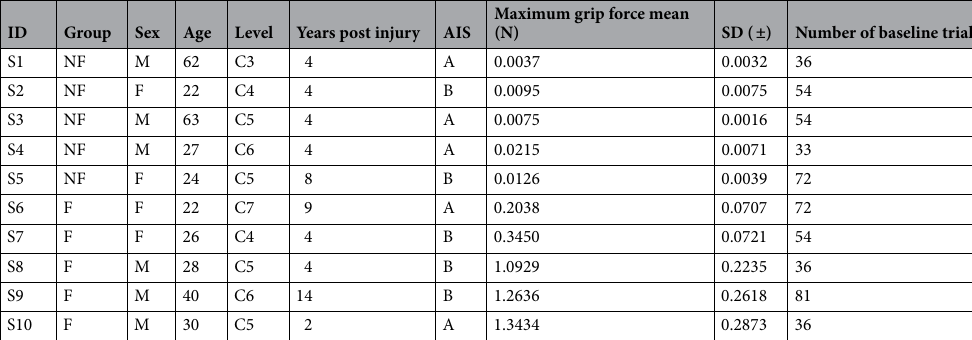
Table 1. Demographic and baseline AIS score as well as the mean, SD and N of maximum grip force (in Newtons) across all baseline trials (6 weeks) for each subject.